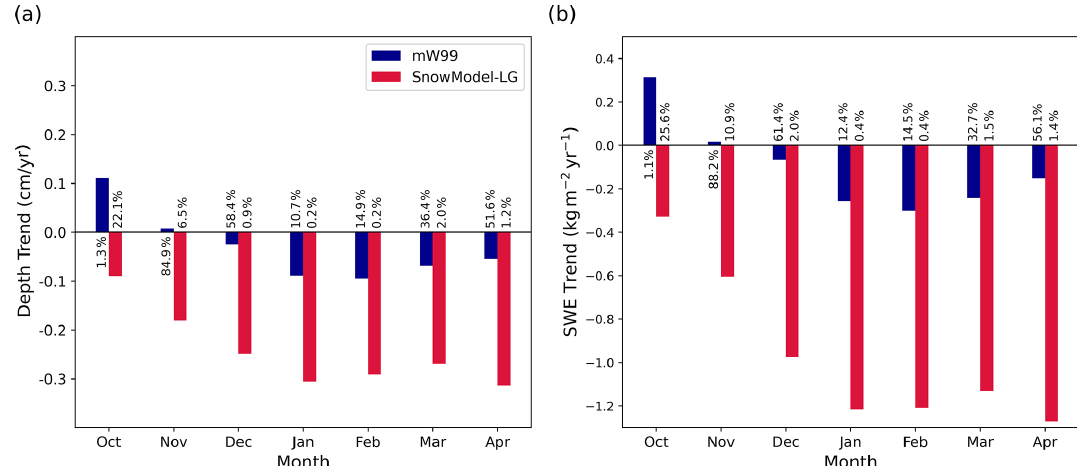
Figure 5. Basin-wide spatial average of point-like trends in (a) snow depth and (b) SWE, from mW99 and SnowModel-LG. Calculated for the Envisat–CS2 period (2002–2018). Significance values (in %) are given at the base of each bar. Only October trends for mW99 are significant at the 5% level, whereas significant negative trends exist in SnowModel-LG for December–April.